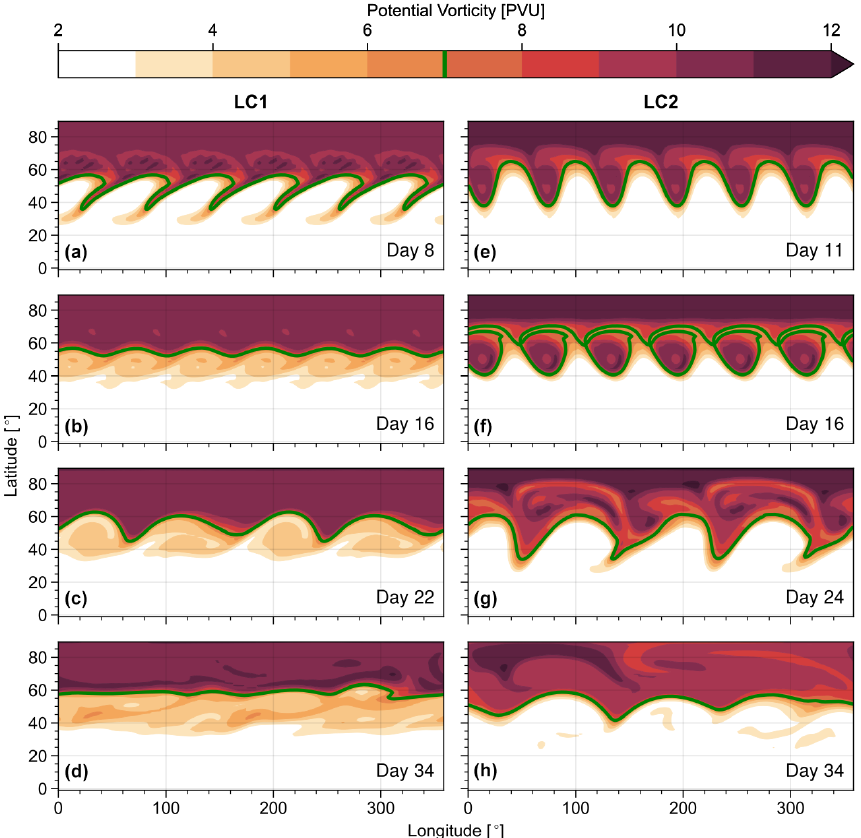
Figure 3. Potential vorticity on the 350K isentrope at different days for LC1 (a–d) and LC2 (e–h) initial conditions and weak initial noise perturbations ( η = 10 − 3 ). The 7PVU contour is highlighted as visual